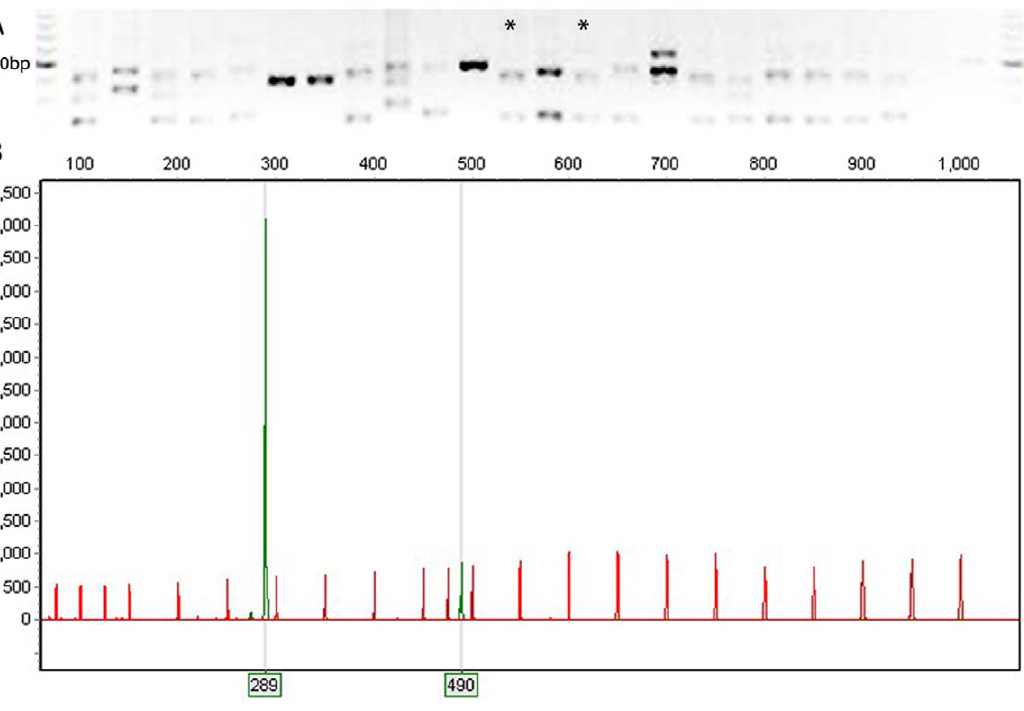
Figure 5. Interspacer region (ISR) amplicons and electropherograms. A. Agarose gel showing ISR amplicons for 24 isolates (two images from a single gel, spliced, inverted and adjusted for brightness and contrast only). Lanes with asterisks indicate isolates with the profile shown in B. The darker band in the ladder on either end of the gel indicates 600 bp. B. Electropherogram showing precisely sized amplicons (in green) in comparison to ROX-labelled size standard with 23 fragments from 50–1000 bp (in red). Peak indicates the strength of the fluorescent signal during electrophoresis, corresponding to the amount of amplicon of that size in the PCR. The isolate represented by this electropherogram would be interpreted as having a major peak at 289 bp and a minor peak at 490 bp.